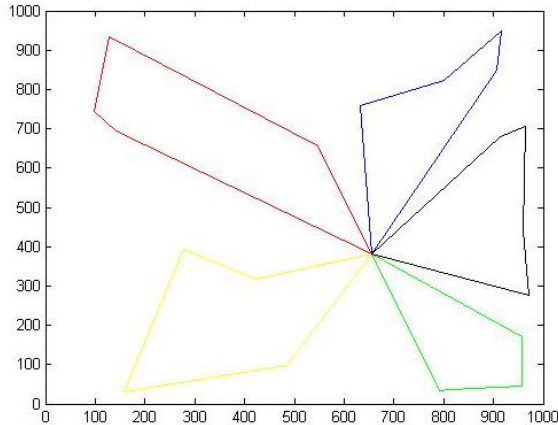
Figure 9. Scenario VI, Average answer is 8608.41 m, average time is 195.9s.